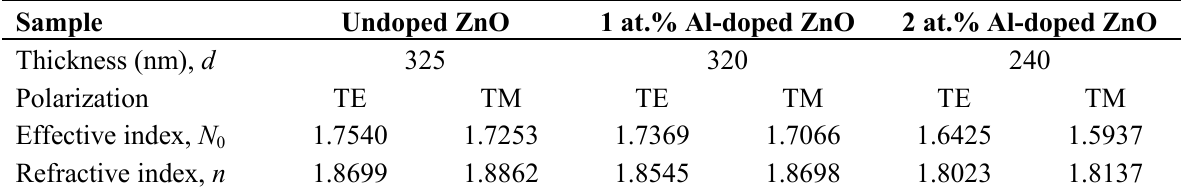
Table 2. Measured fundamental TE and TM effective indices, thickness and refractive indices of the undoped, 1 at.% Al and 2 at.% Al-doped 7-layer ZnO thin films. Sample Undoped ZnO Thickness (nm),